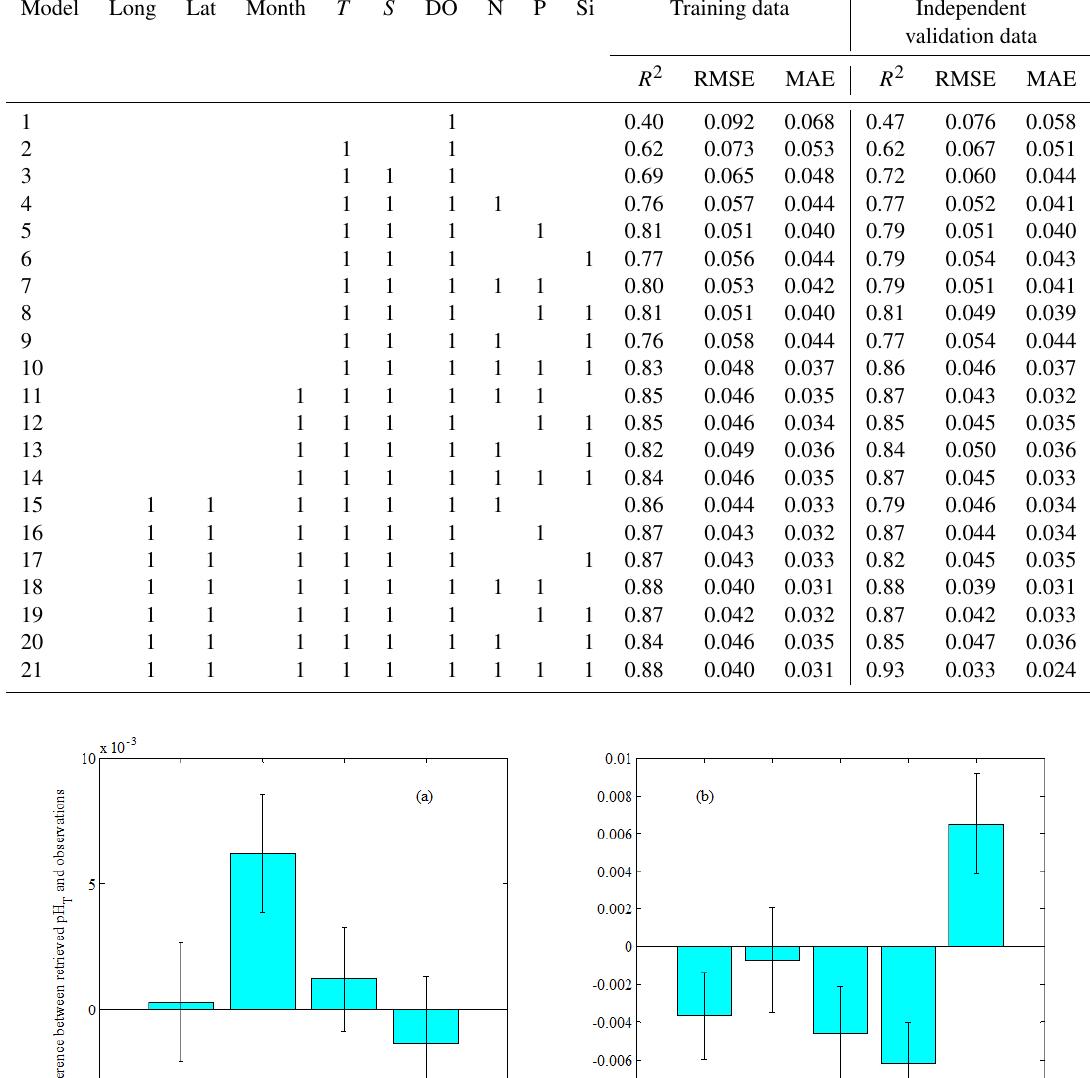
Table 2. Different model structures and their performance in the training step. The variables (Long (longitude), Lat (latitude), Month (month), T (temperature), S (salinity), DO (dissolved oxygen), N (nitrate), P (phosphate), Si (silicate)) marked with 1 represent the input variables. Skill statistics include the coefficient of determination ( R 2 ), the root mean square error (RMSE) and the mean absolute error (MAE).